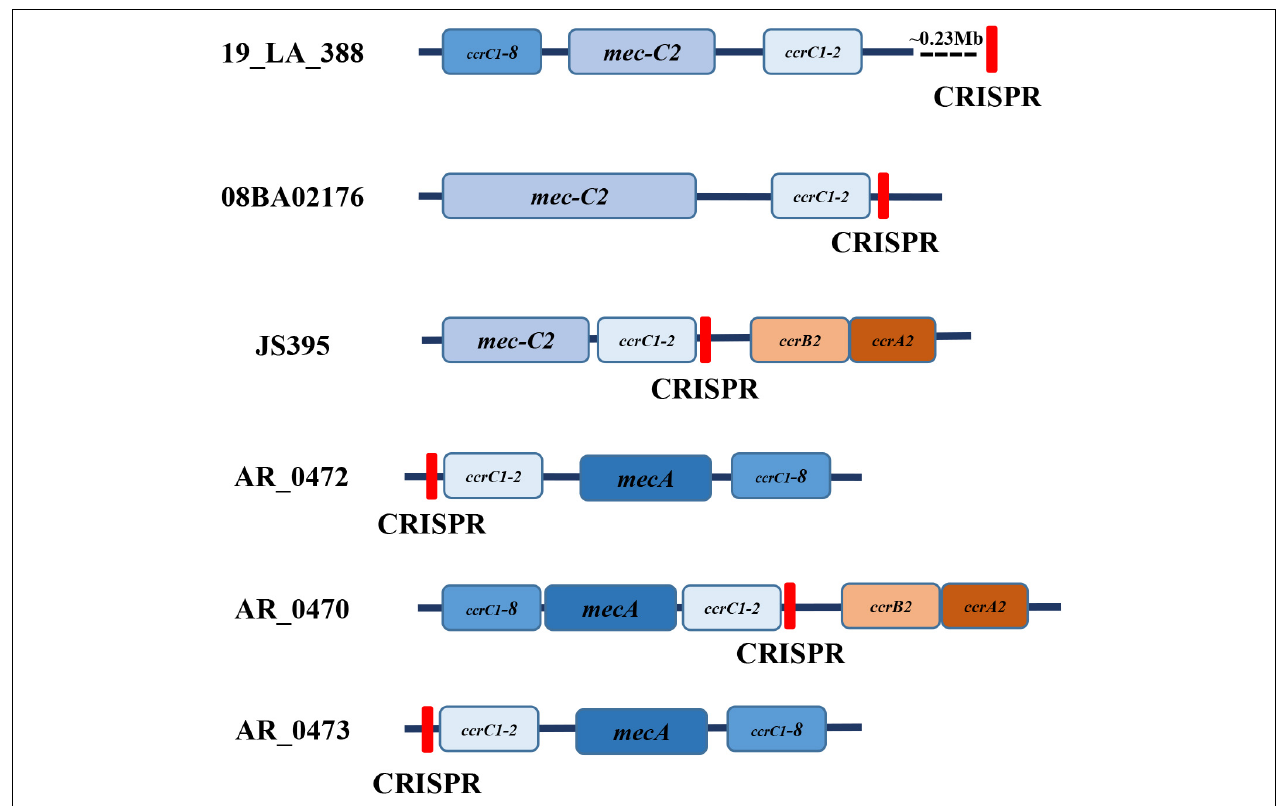
FIGURE 1 | The position of CRISPR in MRSA. Strain 19_LA_388 is an example of strains carrying orphan CRISPR. The complete CRISPR-Cas systems in strain 08BA02176, JS395, AR_0472, AR_0470, and AR_0473 are in the J1 region.